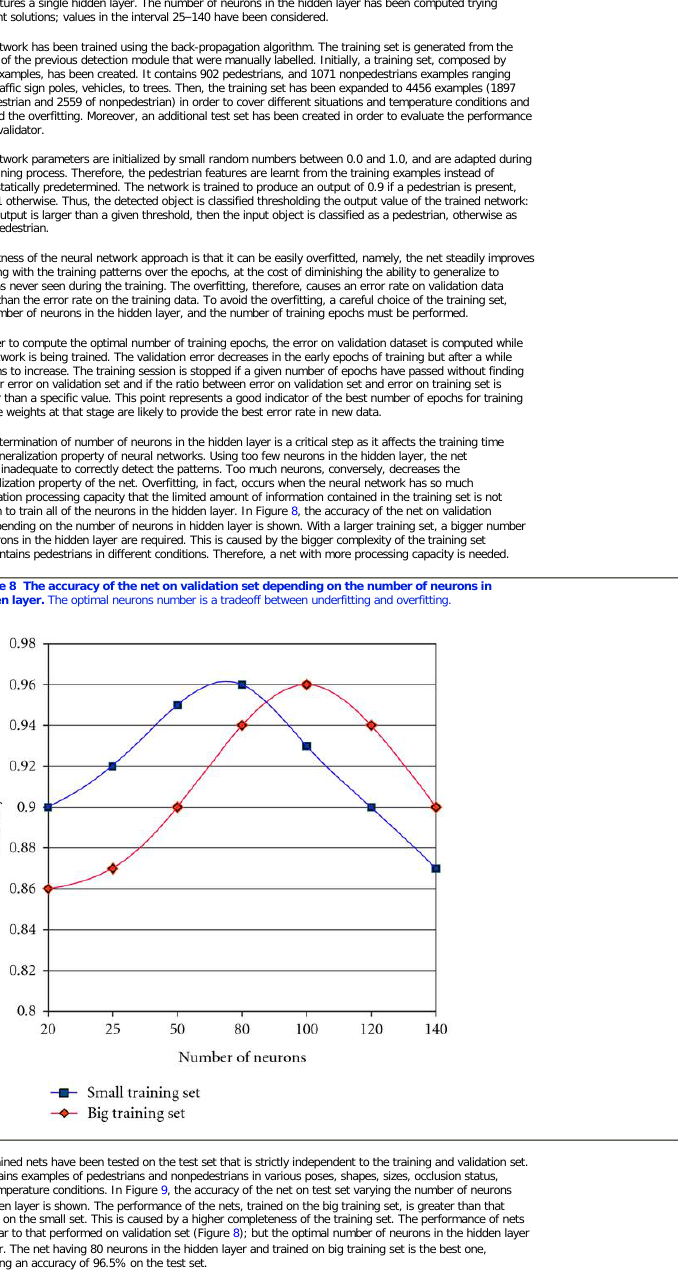
Figure 9 The accuracy of the net on test set depending on the number of neurons in hidden